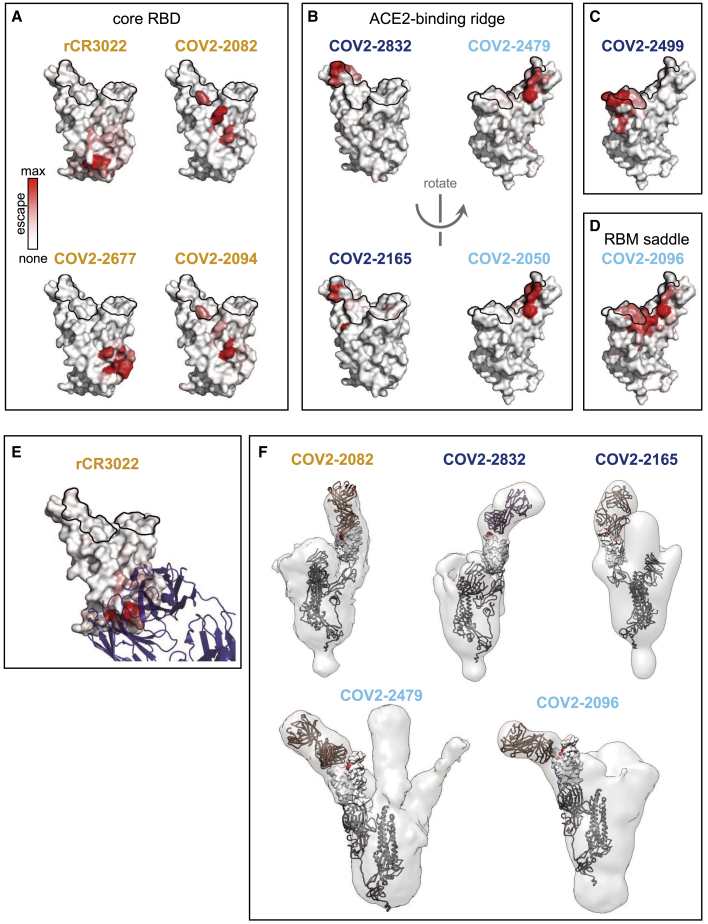
Structural Mapping of Antibody Binding and Escape(A–D) For each antibody, the structure shows the RBD surface colored by the largest-effect escape mutation at each site, with white indicating no escape and red indicating the strongest escape mutation for that antibody. ACE2 contact residues are outlined in black. Antibodies are arranged by structural epitope: (A) core RBD, (B) ACE2-binding ridge, (C) the opposite edge of the RBM, or (D) the saddle of the RBM surface.(E) Crystal structure of the rCR3022-bound RBD (PDB: 6W41; Yuan et al., 2020), with Fab in purple, ACE2 contact sites outlined, and RBD colored according to sites of escape as in (A).(F) For 5 antibodies, Fab bound to SARS-CoV-2 spike ectodomain trimer was visualized by negative-stain EM. The modeled RBD is colored according to sites of escape as in (A). Fab chains are modeled in gold. Antibody names are colored according to Figure 2B: core-binding, orange; RBM-binding, cyan; ACE2 contact site-binding, dark blue. See https://jbloomlab.github.io/SARS-CoV-2-RBD_MAP_Crowe_antibodies/ for interactive versions of the escape-colored structures in (A)–(D). See also Table S2.